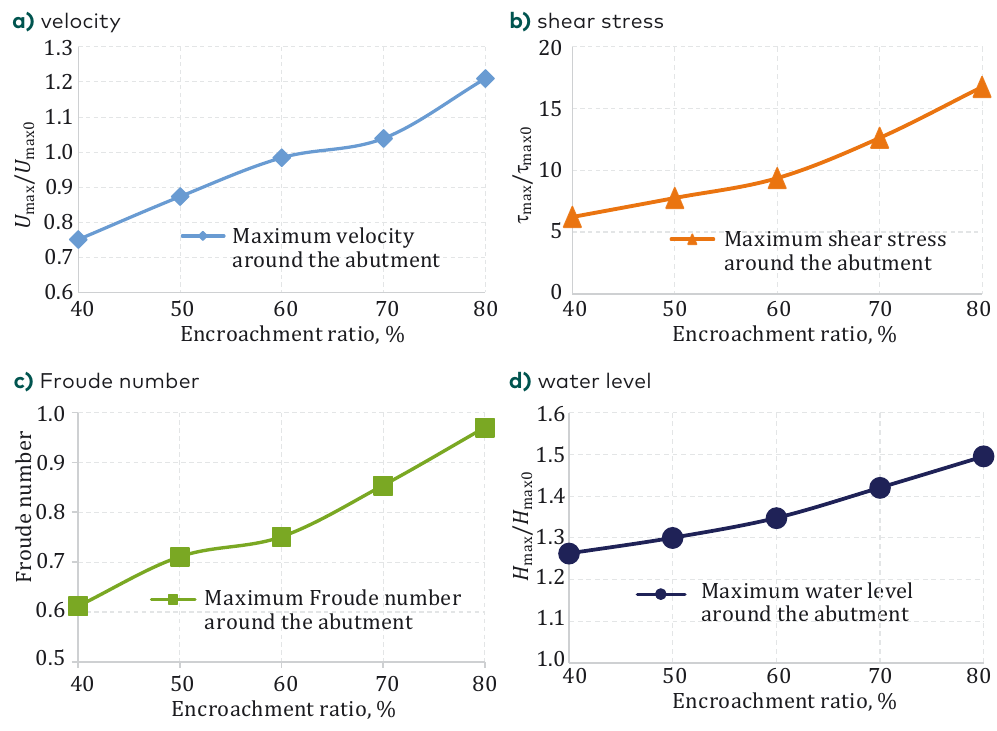
Encroachment ratio, %